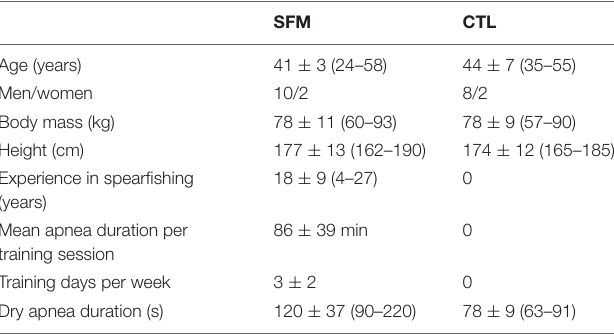
TABLE 1 | Spearfishermen (SFM, n = 12) and control (CTL, n = 10)